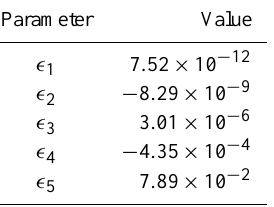
Table 4. Parameters of the error function of the FAM, Eq.